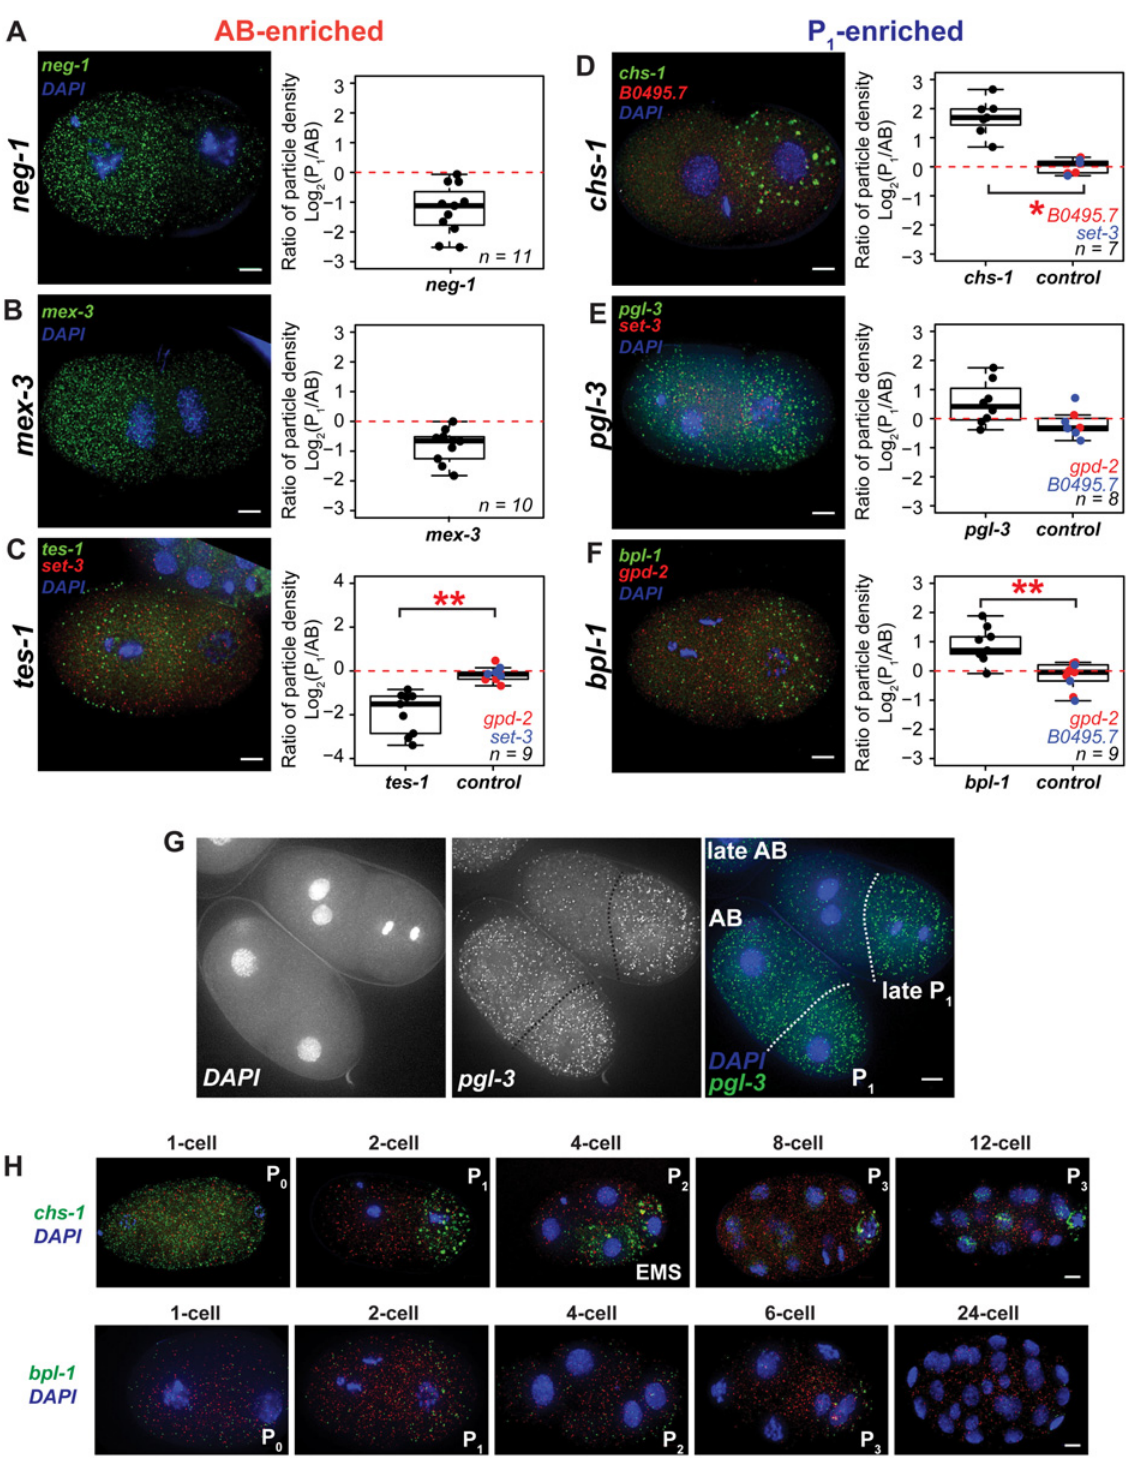
Fig 3. Quantitative in situ hybridization using smFISH probes. (A-F) Three AB-enriched, three P 1 -enriched, and three symmetric transcripts were imaged using sets of smFISH probes. (A-B) Images of wild type ( N2) embryos grown at 20°C, fixed, and hybridized with mex-3 or neg-1 probes are shown. Ratios of particle density are reported (see Materials and Methods). Positive values indicate greater P 1 cell particle densities; negative values indicate greater AB cell densities. neg-1 ranked #4 and mex-3 ranked #42 of 80 AB-enriched transcripts when ordered by P value. neg-1 (n = 11); mex-3 (n = 10). (C-F) tes-1 , chs-1 , pgl-3 , and bpl-1 were multiplexed with control probe sets labeled with a different fluorophore (hybridizing to either gpd-2 , set-3 , or B0495 . 7) to image both